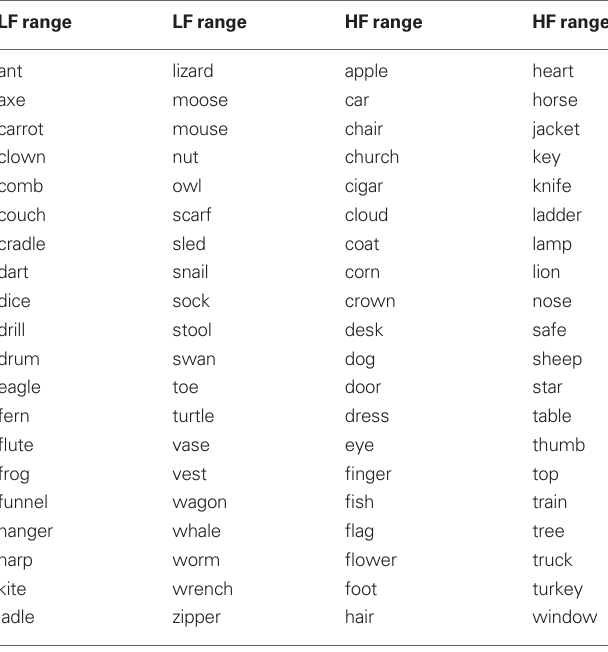
LF, low frequency; HF, high